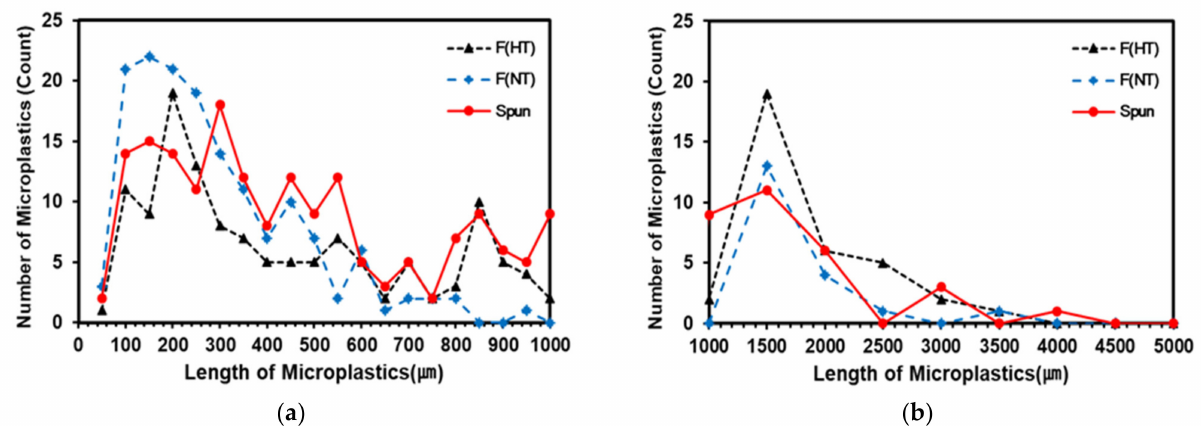
Figure 6. Frequency distribution diagram of microplastics length. ( a ) Length of microplastics from 0 µ m to 1000 µ m (interval: 100 µ m) ( b ) Length of microplastics from 1000 µ m to 5000 µ m (interval: 500 µ m).